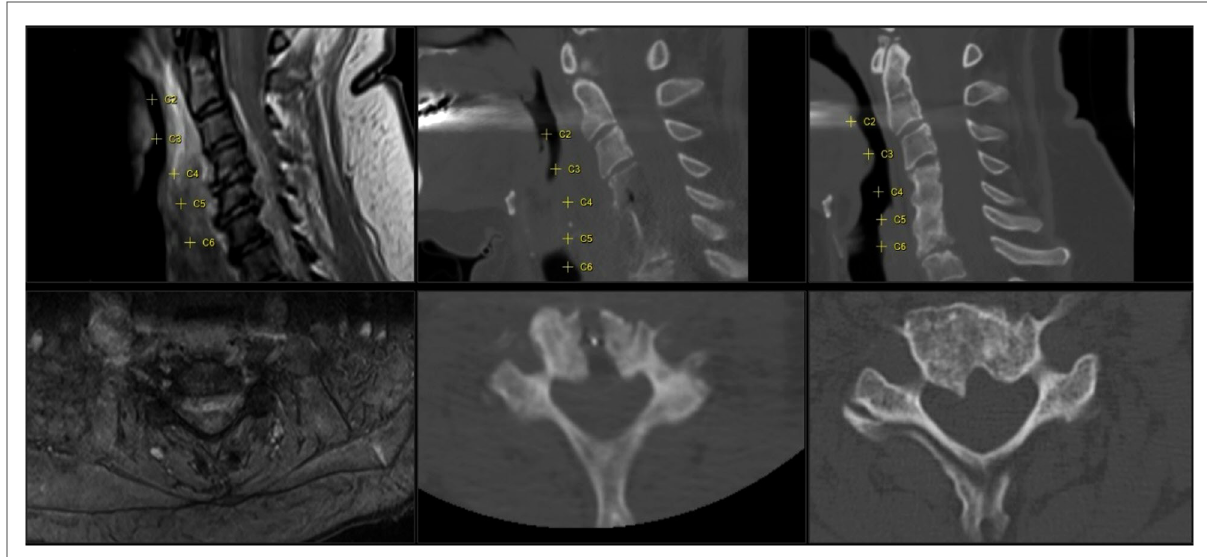
FIGURE 3 Imaging of case 2 with a cervical abscess extending from C2 to C7. Left images show the pre-operative MRI sagittal and axial view (T2 with gadolinium). Middle images show the postoperative CT (CT bone view, sagittal and axial view); the anterior transvertebral midline decompression is viewed from C4 to C6. Axial view shows corpus C5. Right images show a follow-up CT at 4 months (CT, bone view, sagittal and axial view); ossi fi cation of the gutter can be seen and vertebral fusion of C4 – 6.